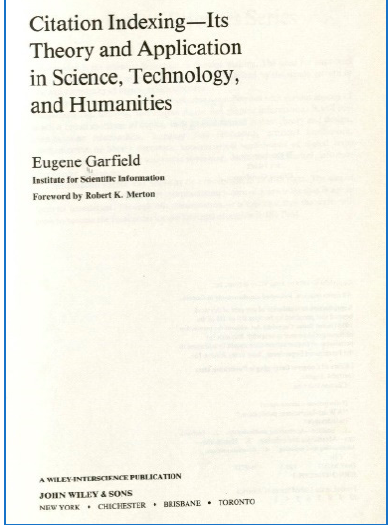
Figure 3. Garfield’s book on citation indexing that laid out the core concepts of the SCI.